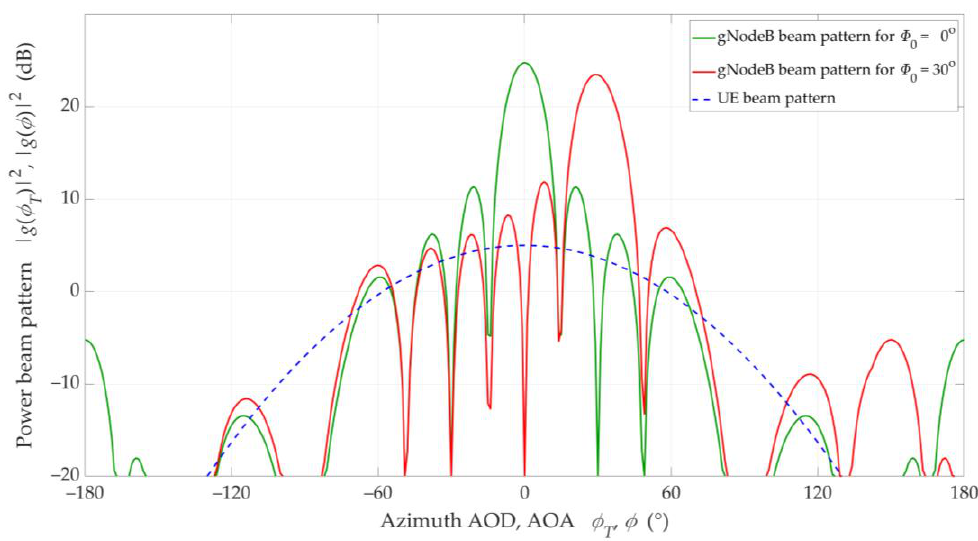
Figure 4. Antenna beam patterns of 1 × 1 UE and 12 × 8 gNodeB for Φ 0 = 0° and Φ 0 = 30° [32]. The simulations were carried out for an urban macro (UMa) environment that is char- acterized by a normal delay profile with the rms delay spread equal to 266 ns [14]. To model the channel transmission properties, we adopted the TDLs with the 3GPP standard [14], i.e., TDL-D and TDL-B for LOS and NLOS conditions, respectively. To estimate